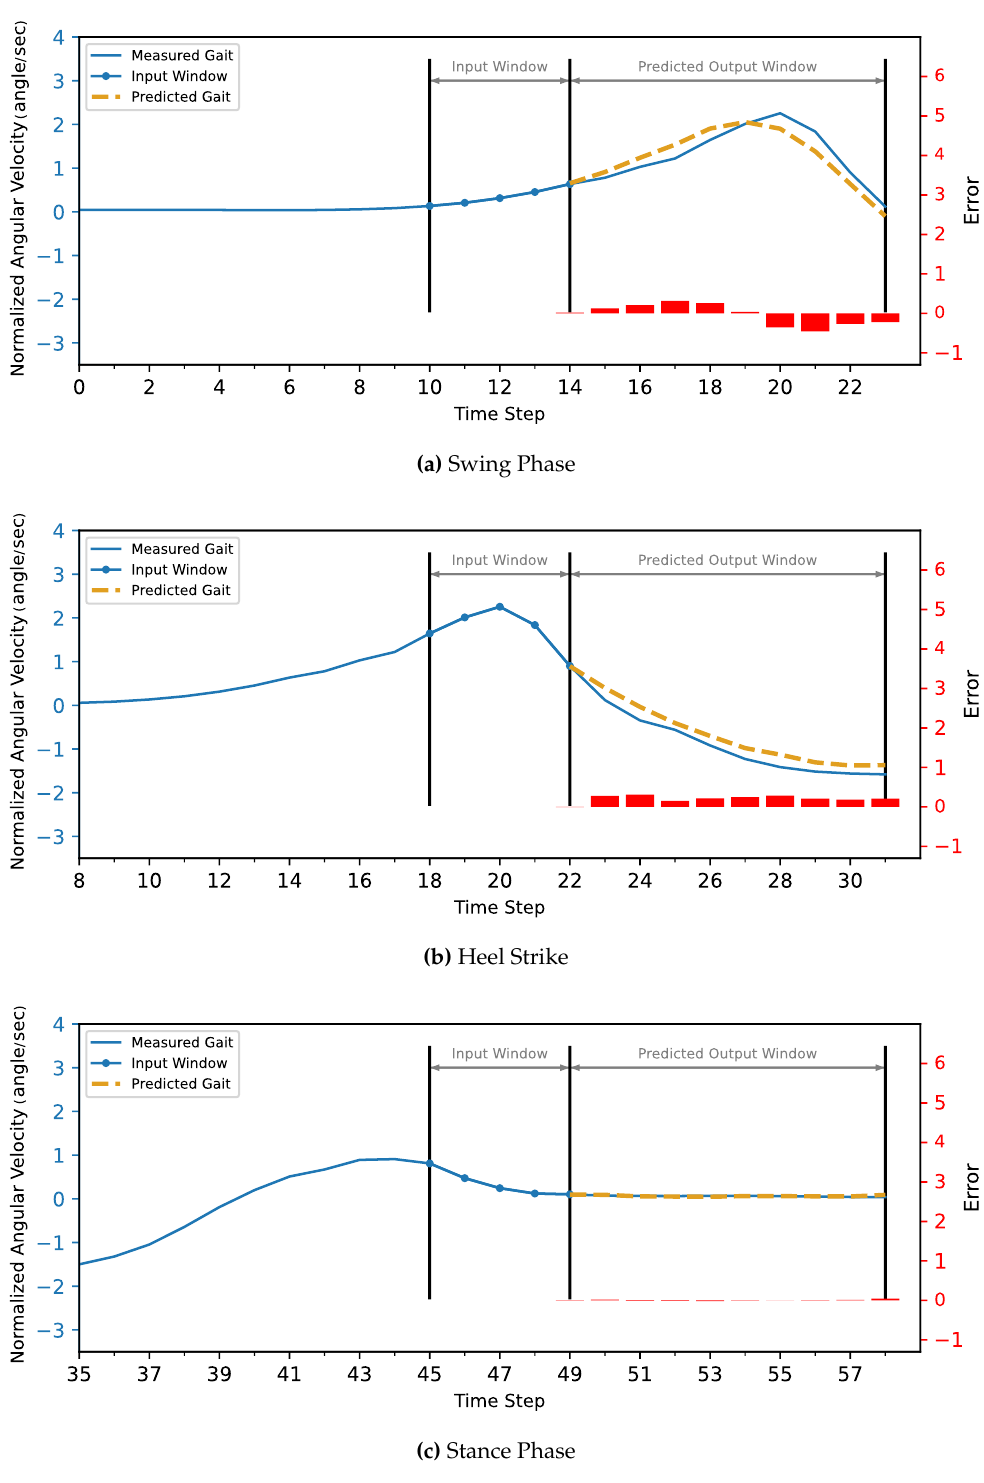
Figure 9. The MLP model with CGP provided 10 time steps ahead prediction for z-score normalized angular velocity of the foot of the inter-subject. The angular velocities are normalized to have zero mean and unit variance. The actual gait is shown in blue, and the predicted trajectory is shown in gold (dashed).